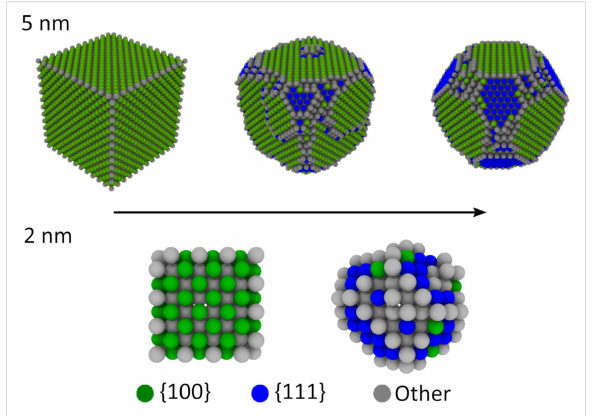
Figure 4: The transition of 5 and 2 nm NPs into rounded shapes bounded by energetically favorable surfaces. Atoms are colored ac- cording to their crystallographic surface